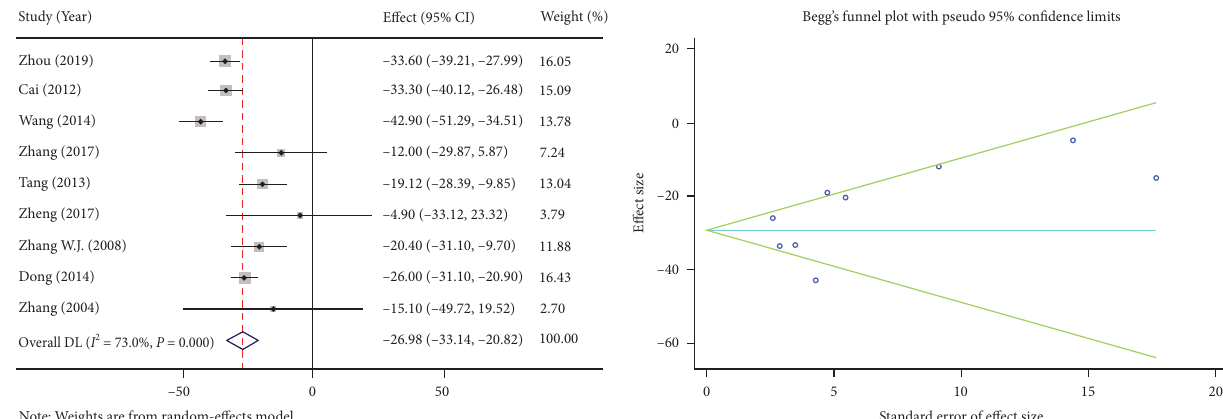
Overall DL ( I 2 = 73.0%, P = 0.000)